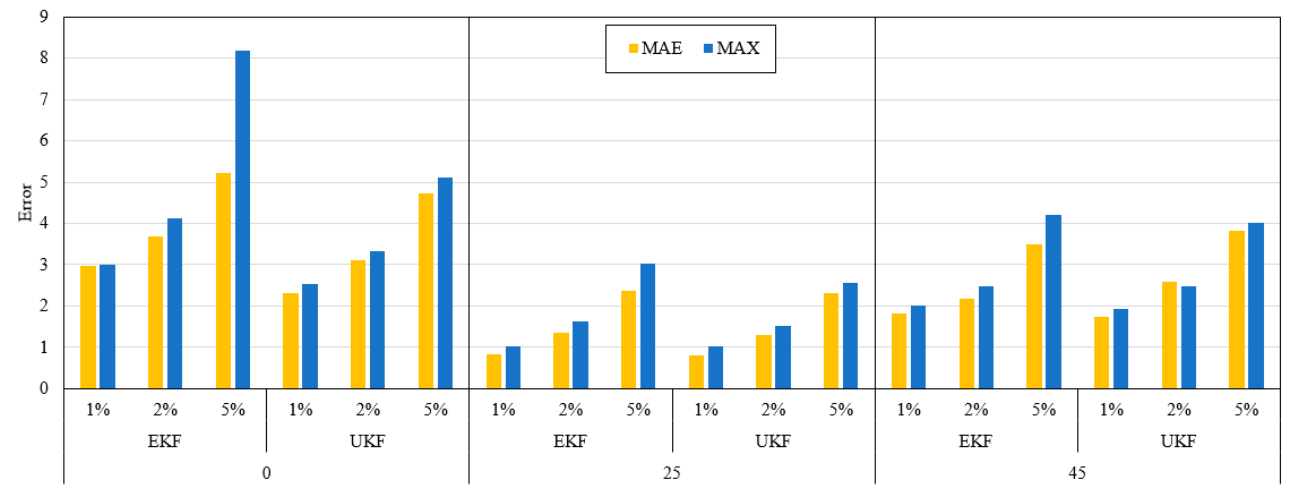
Figure 12. Comparison of overall EKF and UKF performances according to operating temperature including input noise.